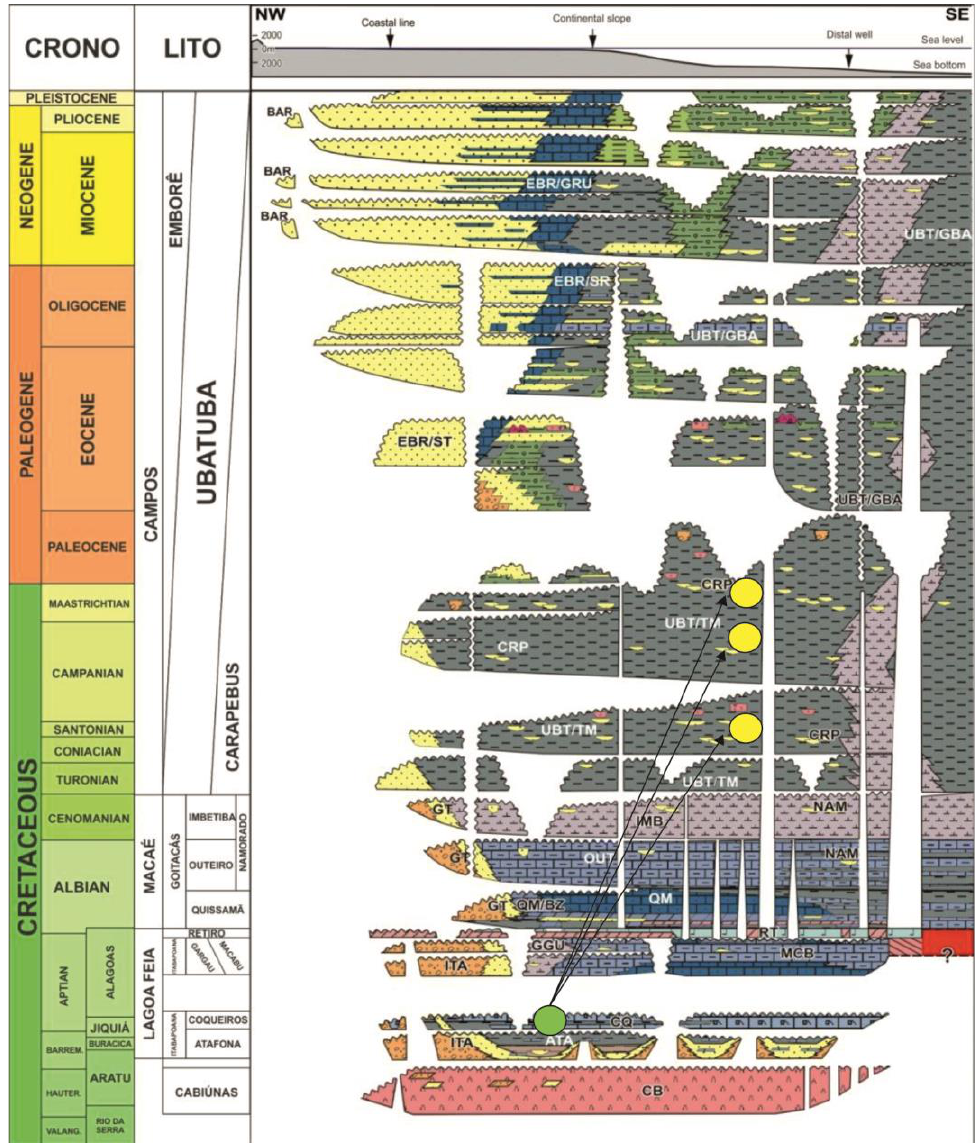
Figure 2. Stratigraphic chart of the Campos Basin, adapted from Portella [7], showing the Lagoa Feia-Carapebus petroleum system. The source rocks of the Lagoa Feia Formation are indicated by the green circle and the turbidite sandstone reservoirs of the Carapebus Formation are indicated by the yellow circles. The seal rocks are the shales of the Ubatuba Formation